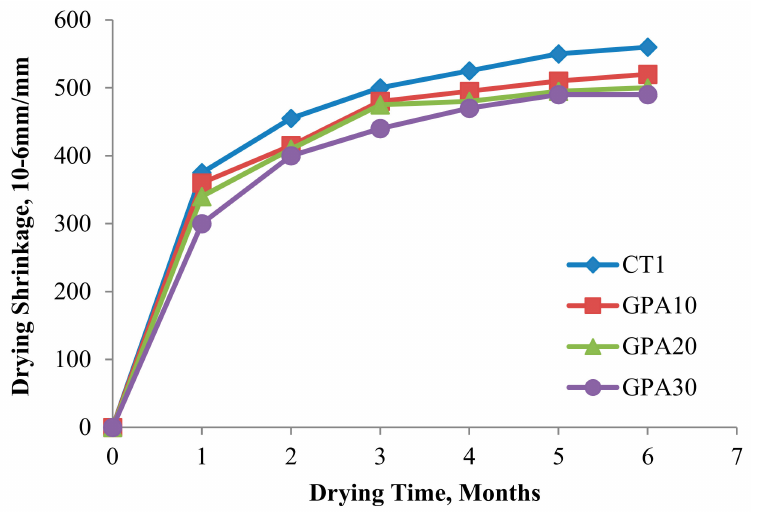
Figure 5. Effect of POFA as a SCM on drying shrinkage [30]. Annotations: GTI contains 0% POFA, GPA10—10%, GPA20—20%, GPA30—30%. Reprinted with permission from Elsevier